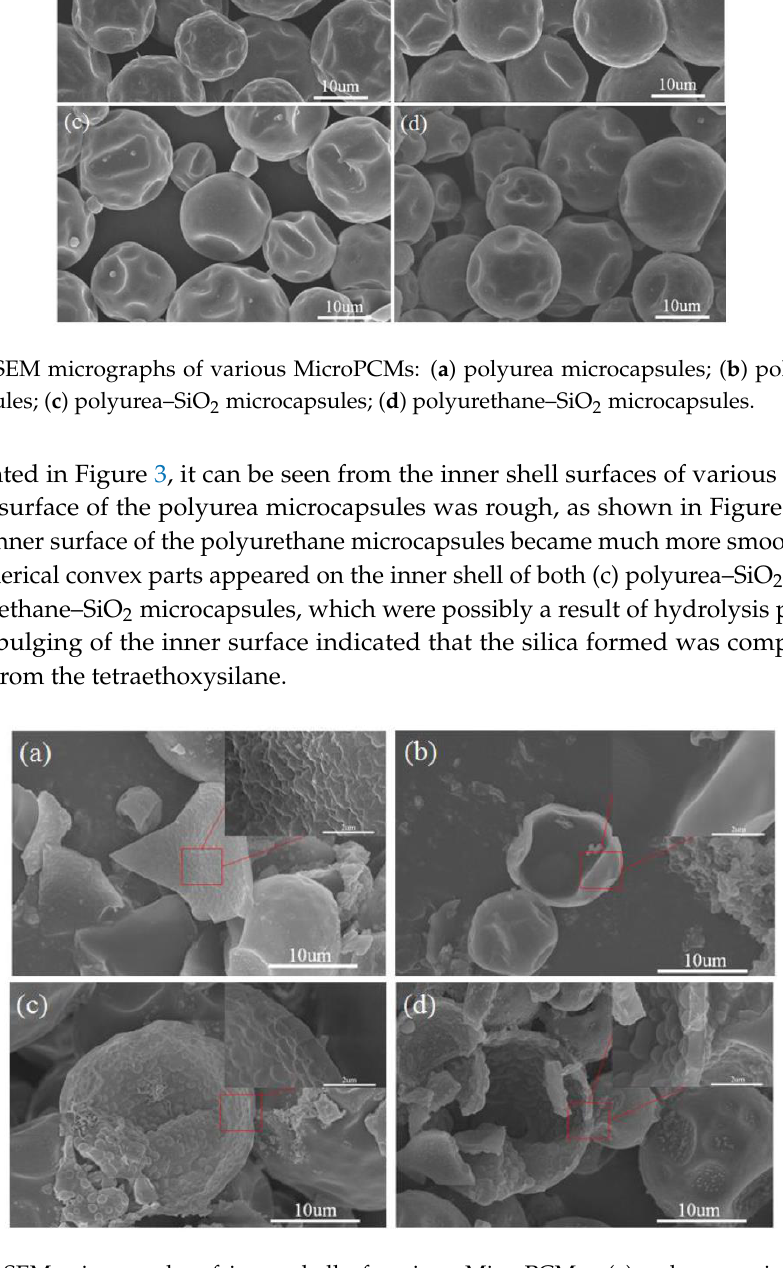
Figure 3. SEM micrographs of inner shell of various MicroPCMs: ( a ) polyurea microcapsules; ( b ) polyurethane microcapsules; ( c ) polyurea – SiO 2 microcapsules; ( d ) polyurethane – SiO 2 microcapsules.